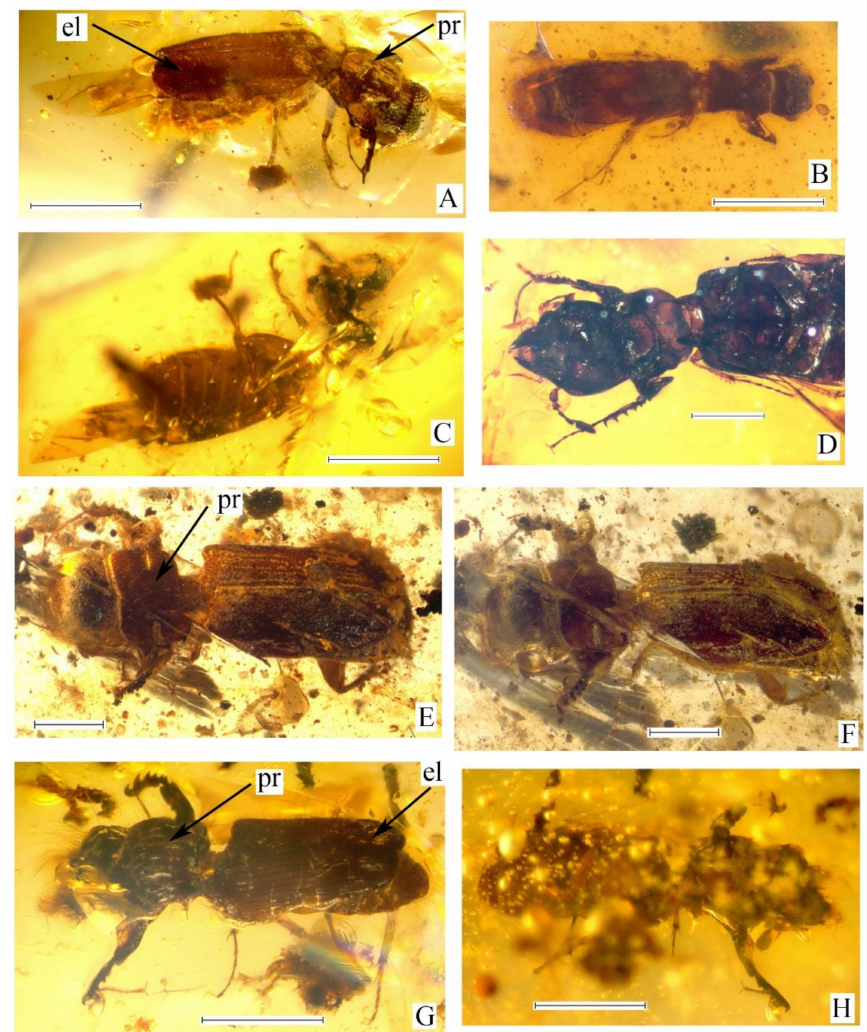
Figure 1. Poinarinius spp. in Myanmar amber: ( A ) P . aristovi sp. nov., holotype, male, ISEA MA2016/2, dorso-lateral view; ( B ) P . aristovi sp. nov., paratype, male, ISEA MA 2016/11, dorsal view; ( C ) P. aristovi sp. nov., holotype, male, ISEA MA2016/2, ventro-lateral view; ( D ) P . aristovi sp. nov., paratype, male, ISEA MA2018/14, ventral view; ( E ) P . aristovi sp. nov., paratype, female, ISEA MA2020/27, dorsal view; ( F ) P . aristovi sp. nov., paratype, female, ISEA MA2020/27, dorso-lateral view; ( G ) P . antonkozlovi sp. nov., holotype, female, ISEA MA2020/24, dorso-lateral view; ( H ) P . antonkozlovi sp. nov., holotype, female, ISEA MA2020/24, ventral view. Scale bar 1.0 mm for ( A – C ), ( E – H ); 0.5 mm for ( D ). Abbreviations: pr—pronotum, el—elytral